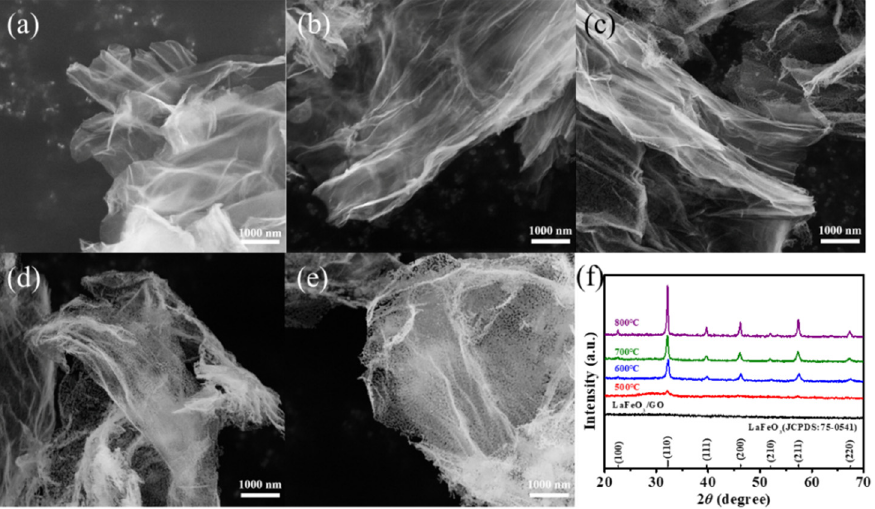
Figure 1. SEM micrographs of LaFeO 3 at different calcination temperatures. ( a ) LaFeO 3 /GO; ( b ) La- FeO 3 /GO calcined at 500 °C; ( c ) LaFeO 3 /GO calcined at 600 °C; ( d ) LaFeO 3 /GO calcined at 700 °C; ( e ) ( b ) LaFeO 3 /GO calcined at 500 ◦ C; ( c ) LaFeO 3 /GO calcined at 600 ◦ C; ( d ) LaFeO 3 /GO calcined at LaFeO 3 /GO calcined at 800 °C; ( f ) XRD patterns of the samples. 700 ◦ C; ( e ) LaFeO 3 /GO calcined at 800 ◦ C; ( f ) XRD patterns of the